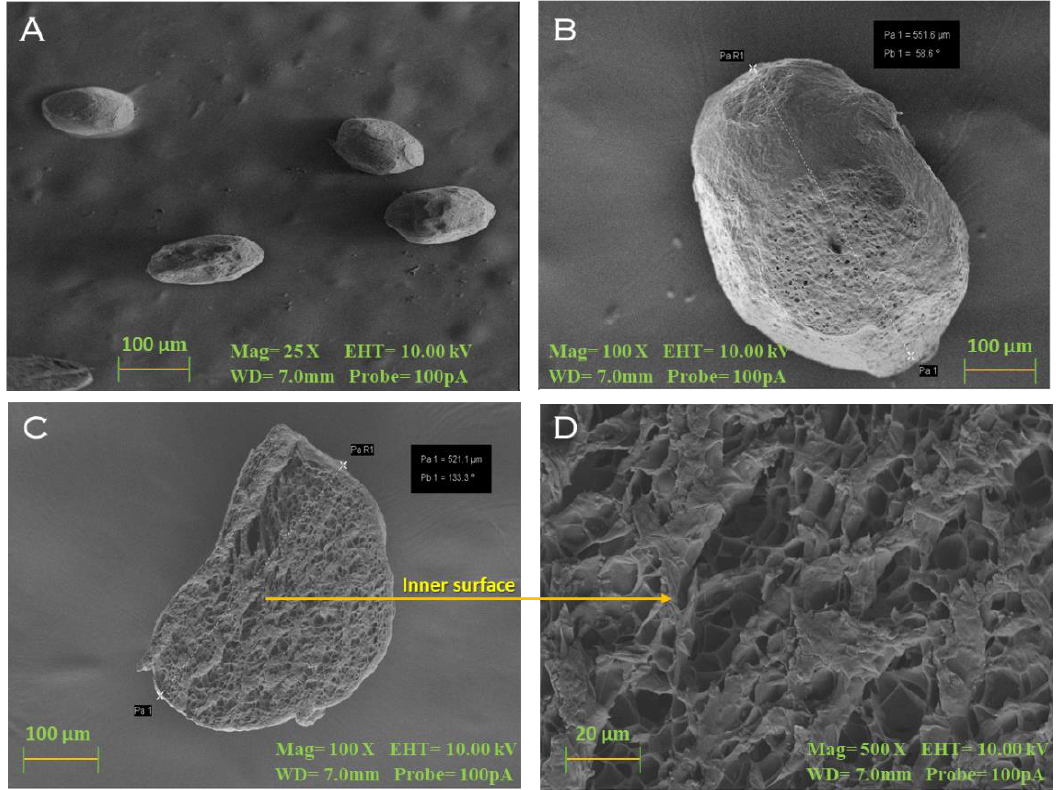
Figure 7. Scanning electron microphotograph of ( A , B ) alginate-BSO dried beads showing the surface morphology (25 × and 100 × ) and the presence of pores and channels in the dried beads slice with the magnification of 100 × ( C ) and 500 × ( D ).